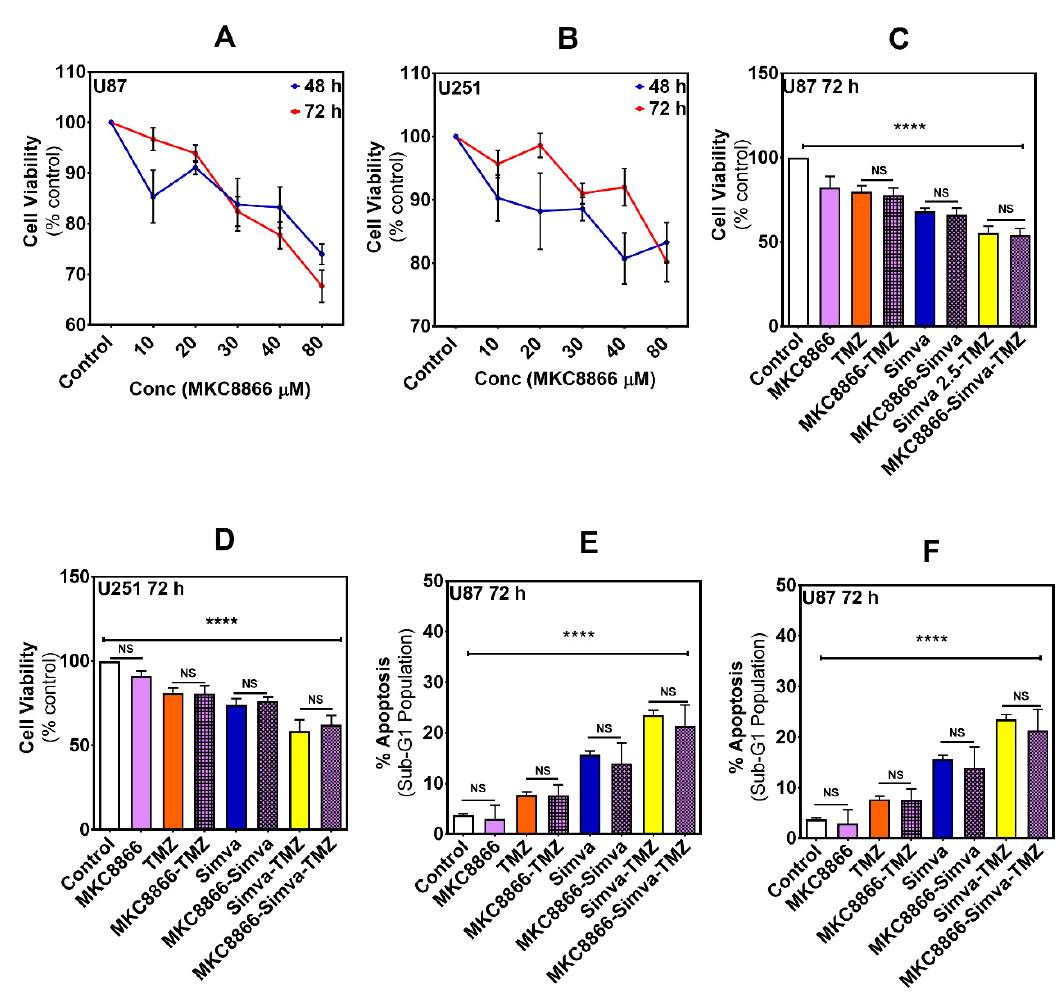
Figure 2. Inositol-requiring enzyme 1 (IRE1 α ) RNase inhibition does not affect Simva–TMZ-induced cell death. ( A , B ) U87 and U251 cells were treated with different concentrations of MKC8866 (IRE-1 α RNAse inhibitor; 10, 20, 30, 40, and 80 µM) for 48 and 72 h, and cell viability was evaluated by 3-(4,5-dimethyl-2-thiazolyl)-2,5-diphenyl-2H-tetrazolium bromide) (MTT) assay. Control cells were treated with the solvent (DMSO) for each time point. MKC8866 significantly reduced cell viability in U87 (30 µM; 48 h, p < 0.05, 72 h, p < 0.001), (40 µM; 48 h, p < 0.05, 72 h, p < 0.0001), (80 µM; 48 h, p < 0.001, 72 h, p < 0.0001) and U251 (80 µM; 48 h, p < 0.05, 72 h, p < 0.0001) cells. ( C , D ) U87 and U251 cells were pretreated with MKC8866 (30 µM) for 4 h and subsequently co-treated with TMZ, Simva, or Simva–TMZ for 72 h. Cell viability was measured by MTT assay. MKC8866 did not significantly change Simva-, TMZ-, or Simva–TMZ-induced cell death in glioblastoma (GBM) cells. ( E , F ) U87 and U251 cells were pretreated with MKC8866 (30 µM) for 4 h and subsequently co-treated with TMZ, Simva, or Simva–TMZ for 72 h. Apoptosis was measured by Nicoletti assay. MKC8866 did not significantly change Simva-, TMZ-, or Simva-TMZ-induced apoptosis in GBM cells. Findings are expressed as the mean ± SD of three independent experiments for MTT assay (15 replicates) and three independent replicates for Nicoletti assay **** p < 0.0001). NS; not significant